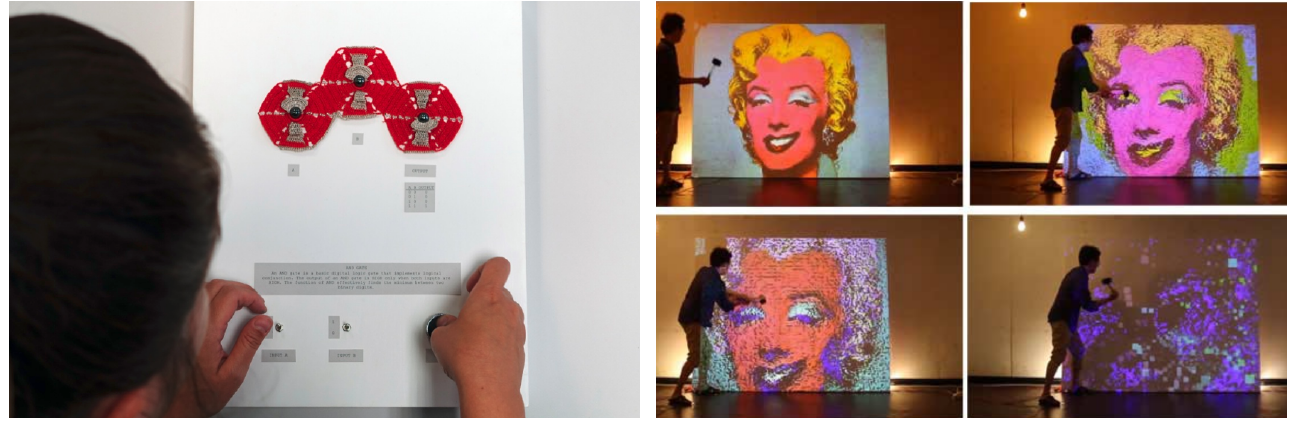
Figure 3: Tangible dialogue genre